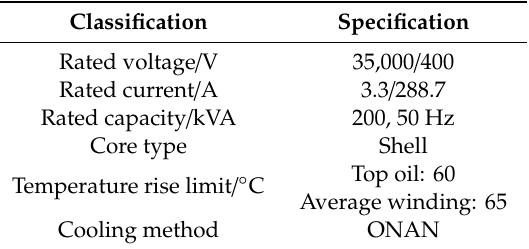
Table 1. Specifications of the transformer.